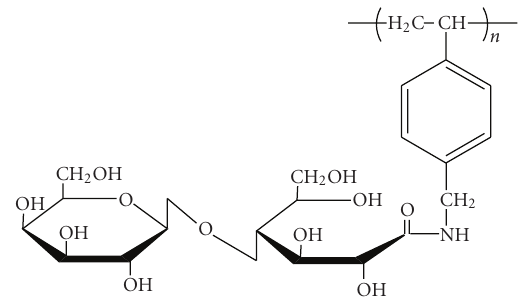
Figure 1: Chemical structure of PVLA, β -galactose-carrying poly-